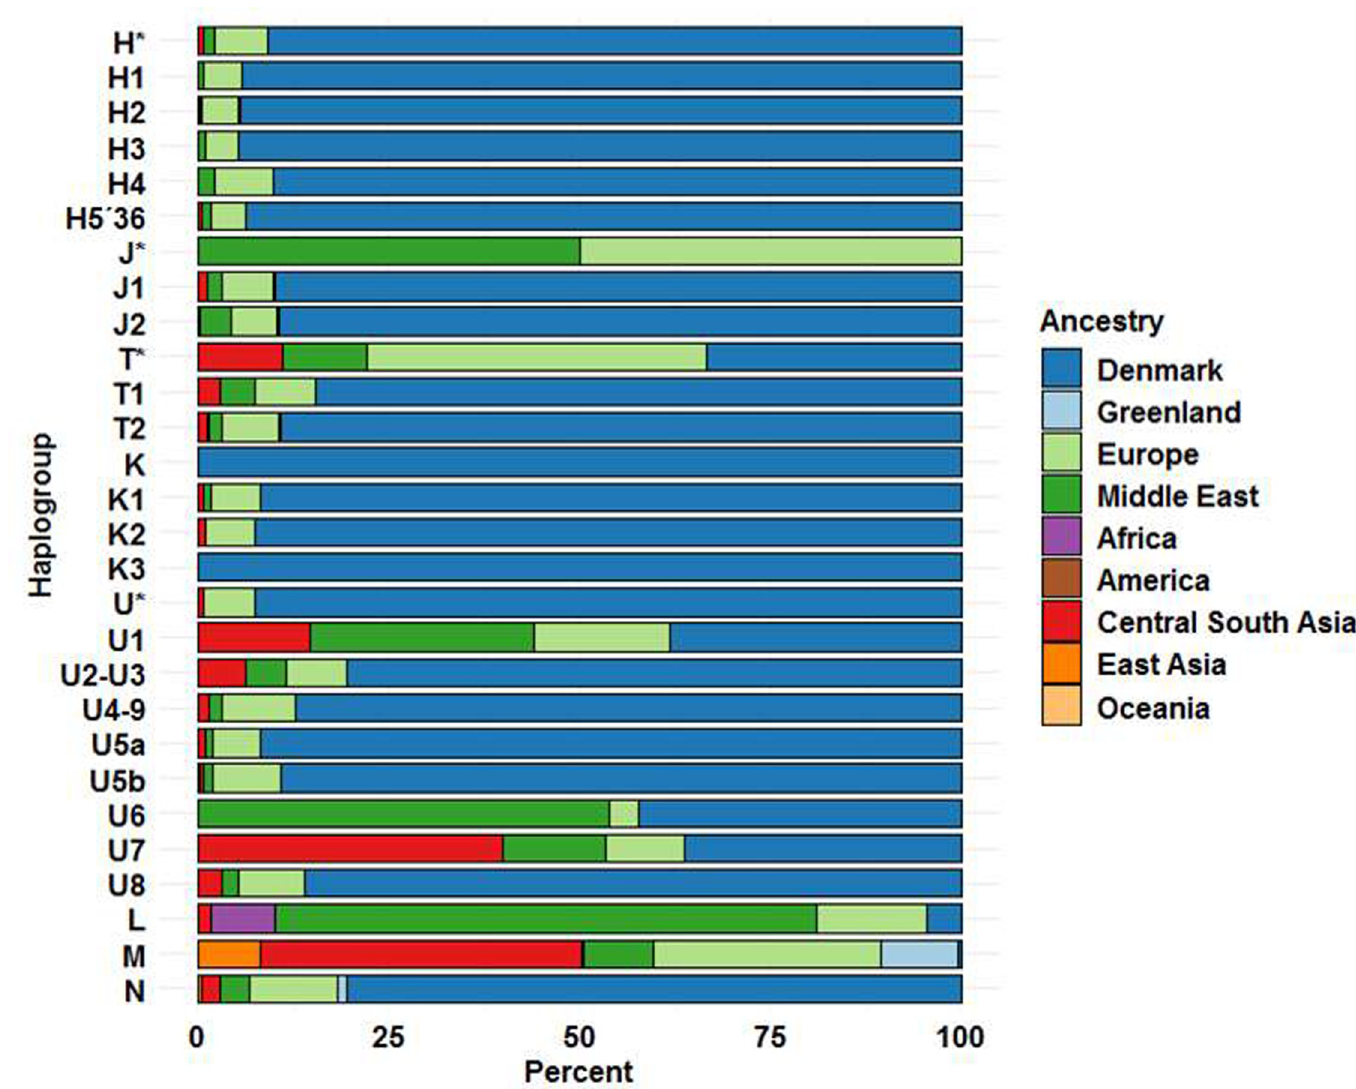
Fig 6. Genomic ancestry of samples as a function of mtDNA hg. (See Materials and Methods for details).